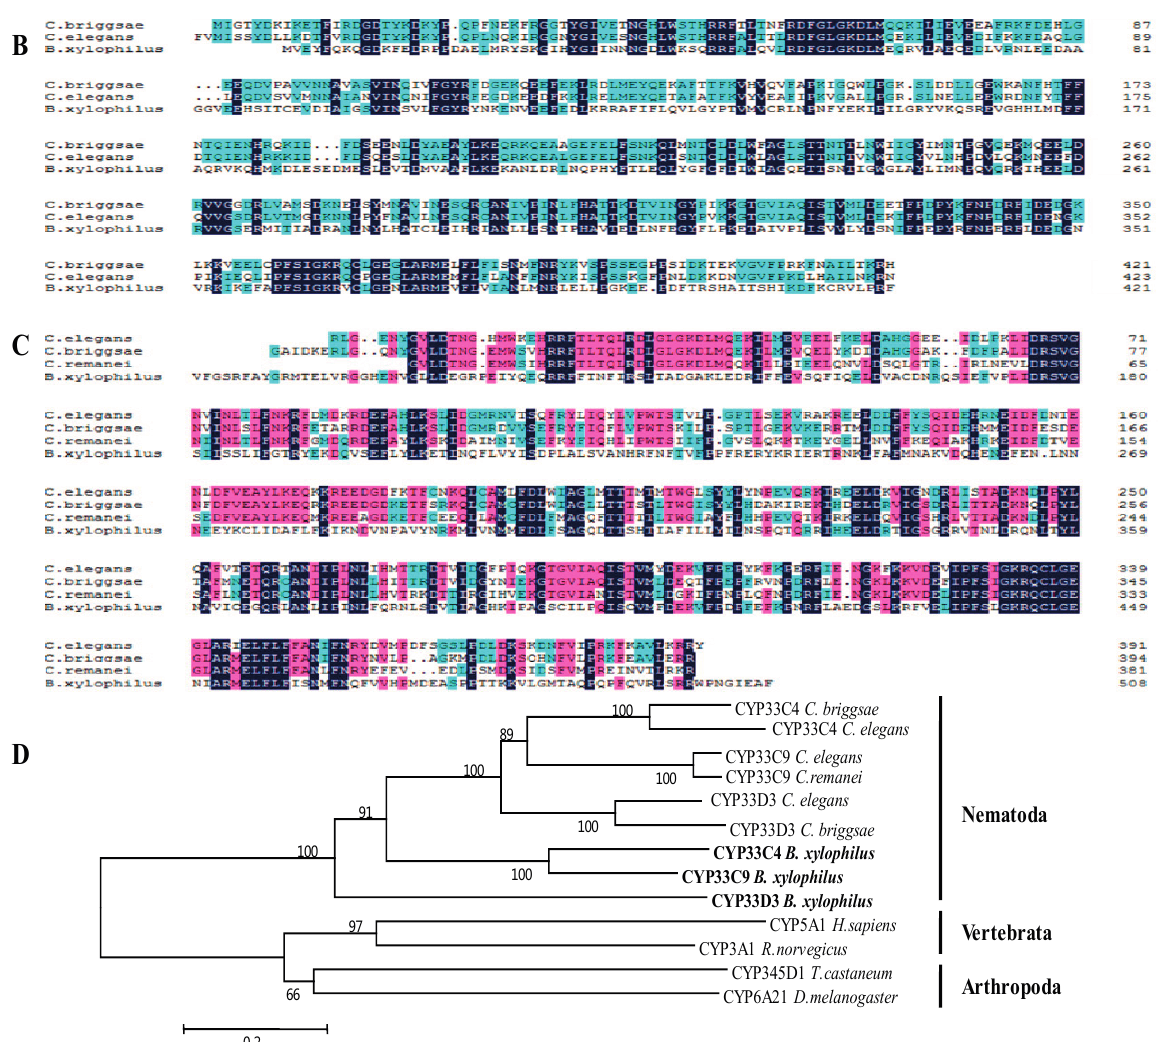
Figure 2. Multiple alignments of predicted BxCYP33C9, BxCYP33C4 and BxCYP33D3 of B. xylophilus with other organism CYP proteins. ( A ) Comparison for protein homolo-gogy of CYP33C9 from B. xylophilus , C. brenneri , C. elegans , C. remanei and C. briggsae